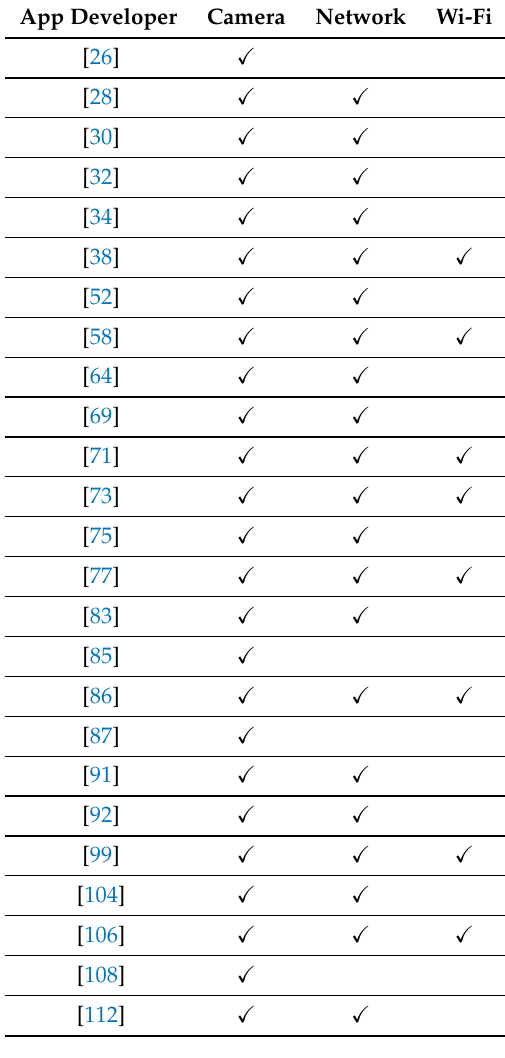
Table 4. Save-Privacy Apps with the Least-Privilege